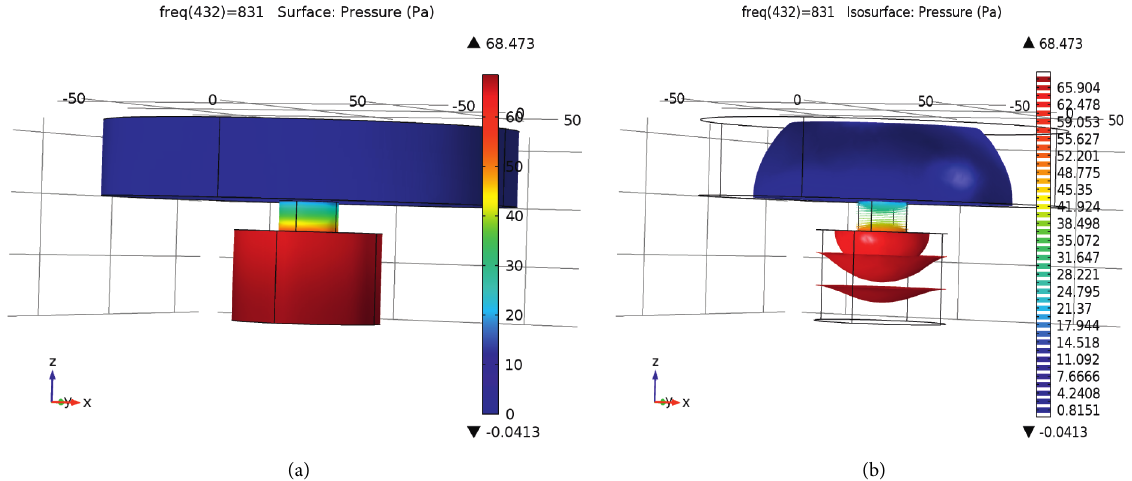
Figure 8: Simulation results of Helmholtz resonator: (a) sound pressure response and (b) sound pressure isosurface.